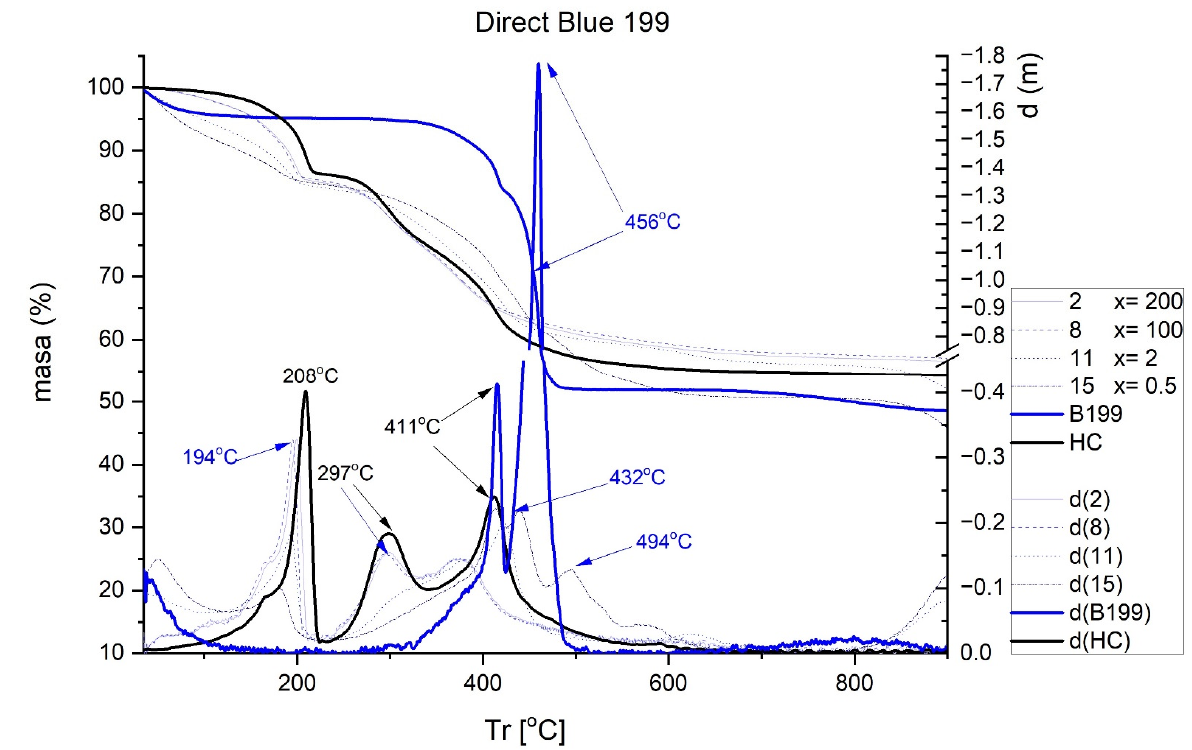
Figure 7. TGA and DTGA of Direct Blue 199 free and adsorbed.